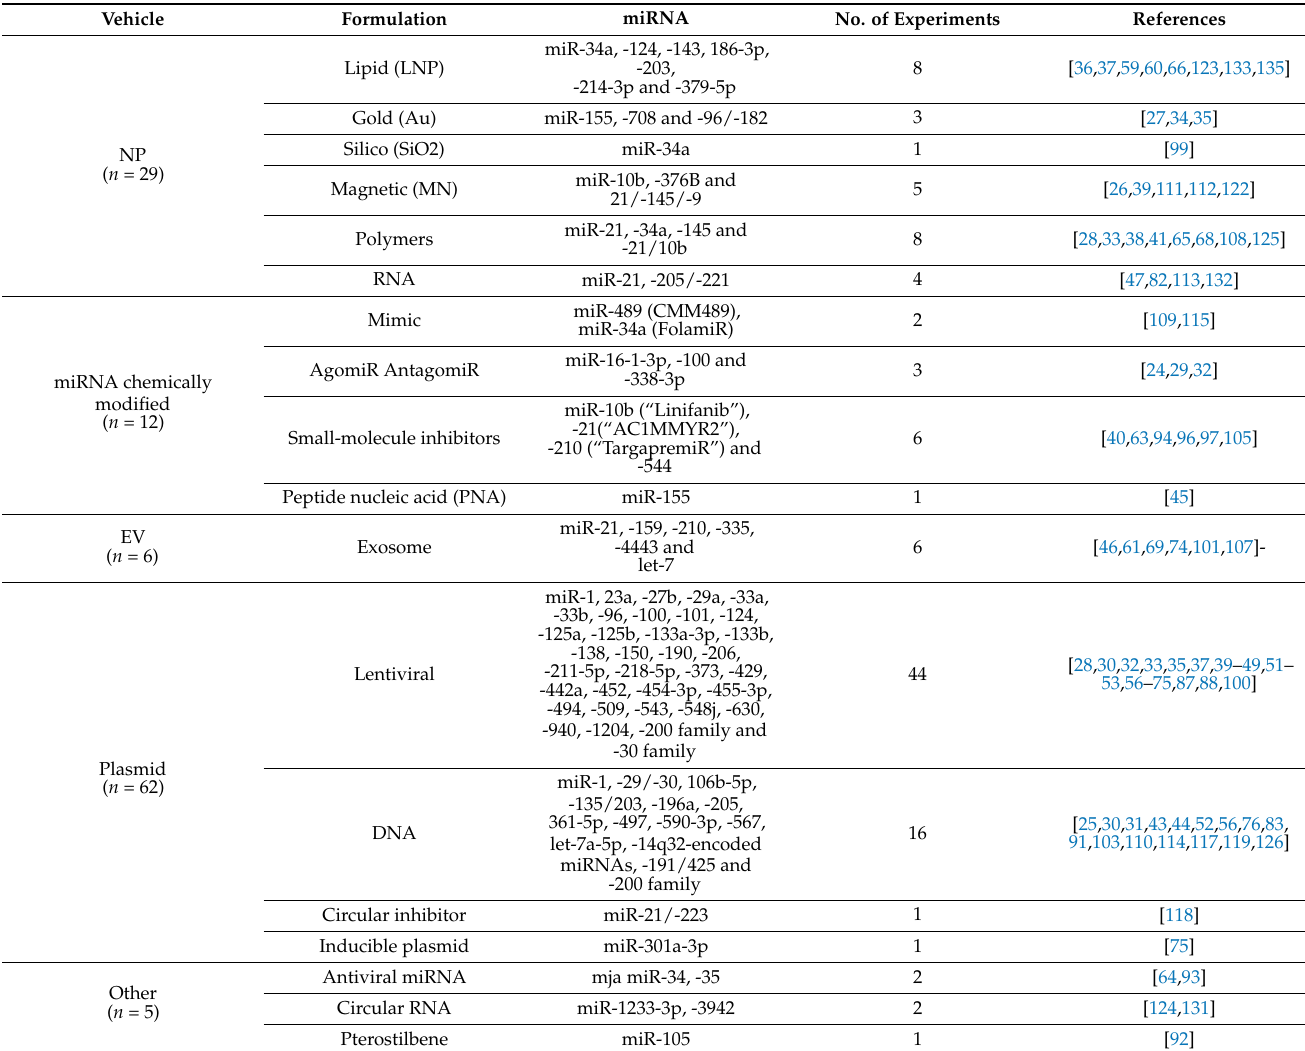
Figure 4. The absolute number of experiments conducted for each miRNA delivery system. NPs: nanoparticles; EVs: extracellular vesicles. Table 4. miRNA delivery system in mice.